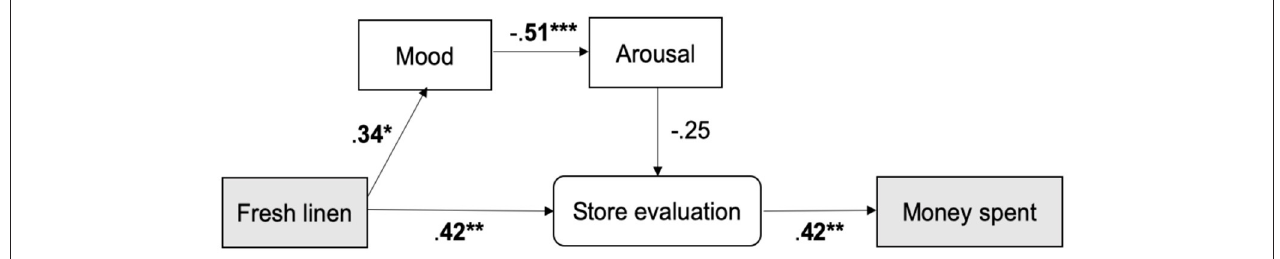
FIGURE 5 | Best fitting model according to structural equation modeling. Store evaluation is a latent variable in this model measured with three